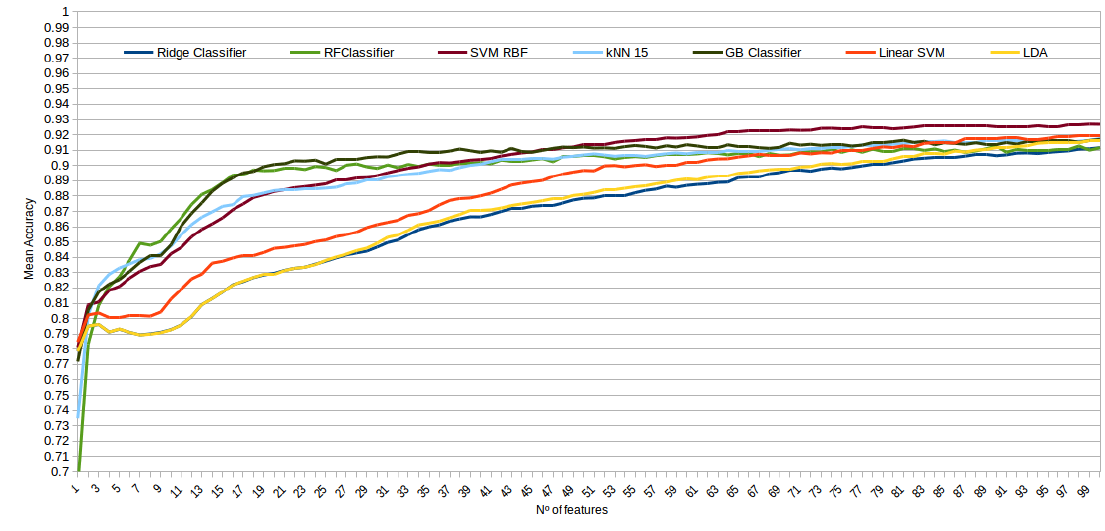
Figure 10. Evolution of the accuracy for each classifier tested with an increasing subset of features obtained with the trace